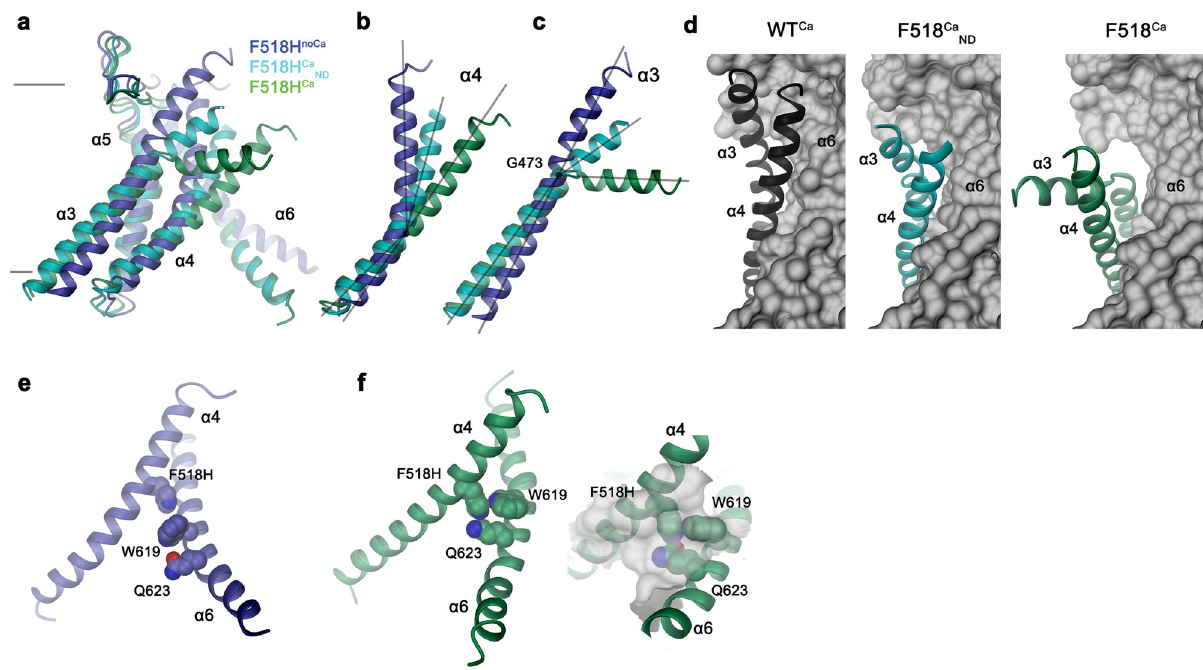
Fig.4|StructuralfeaturesoftheactivatingmutantF518H. Superpositionofthe poreregion of different structures ofF518Hencompassing α -helices 3-6 ( a ), α 4 ( b ) and α 3 ( c ). b , c Lines indicate axes for different helix sections to approximate conformational changes. d Packing interactions of α 3 and 4 (ribbon) with the